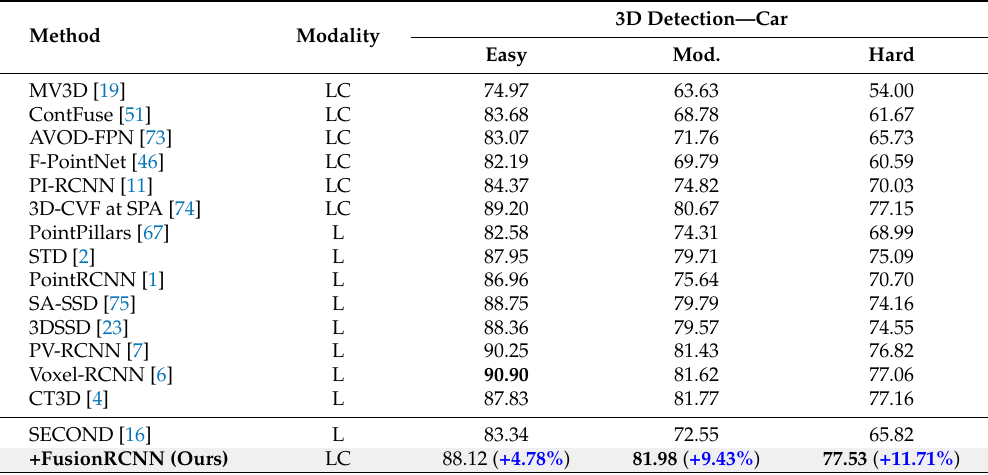
Table 5. Performance comparison on the KITTI test set. The results are reported with AP calculated by 40 recall positions and 0.7 IoU threshold for the car class. L denotes LiDAR-only approaches. LC denotes the methods that combine LiDAR point clouds and camera images. The best results are bolded and performance improvements are painted in